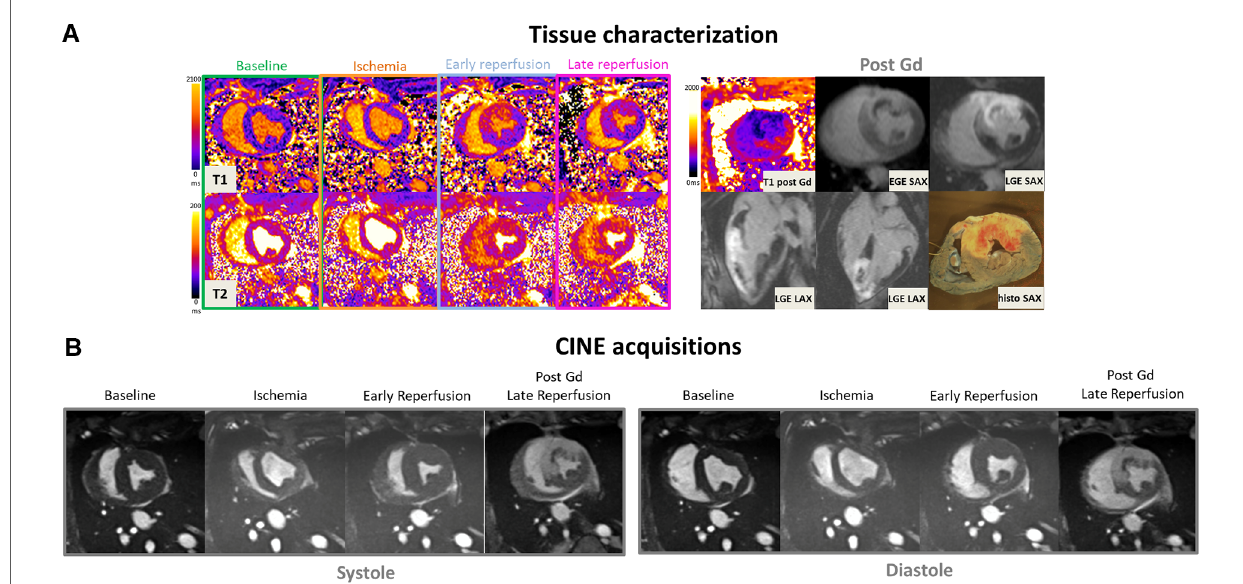
FIGURE 3 ( A : top left) Representative short-axis T1 and T2 maps obtained at baseline, during ischemia, early, and late time-points of the reperfusion in a swine open chest model from the control group. ( B ) CINE bSSFP images are displayed in short axis, in diastole and systole at different time-points. ( A : top-right) Early and late Gadolinium enhanced images (EGE and LGE) matching to the corresponding T1 maps, together with ex vivo macroscopic corresponding mid- ventricular slice after Evans blue dye are also displayed (top-right). Gd hyper-enhanced sectors in post-contrast bSSFP images can be easily identi fi ed, visually matching the EGE and LGE hyperintense areas. These sectors correspond to akinetic segments during ischemia but also where edema immediately and clearly appeared after reperfusion on both T1 and T2